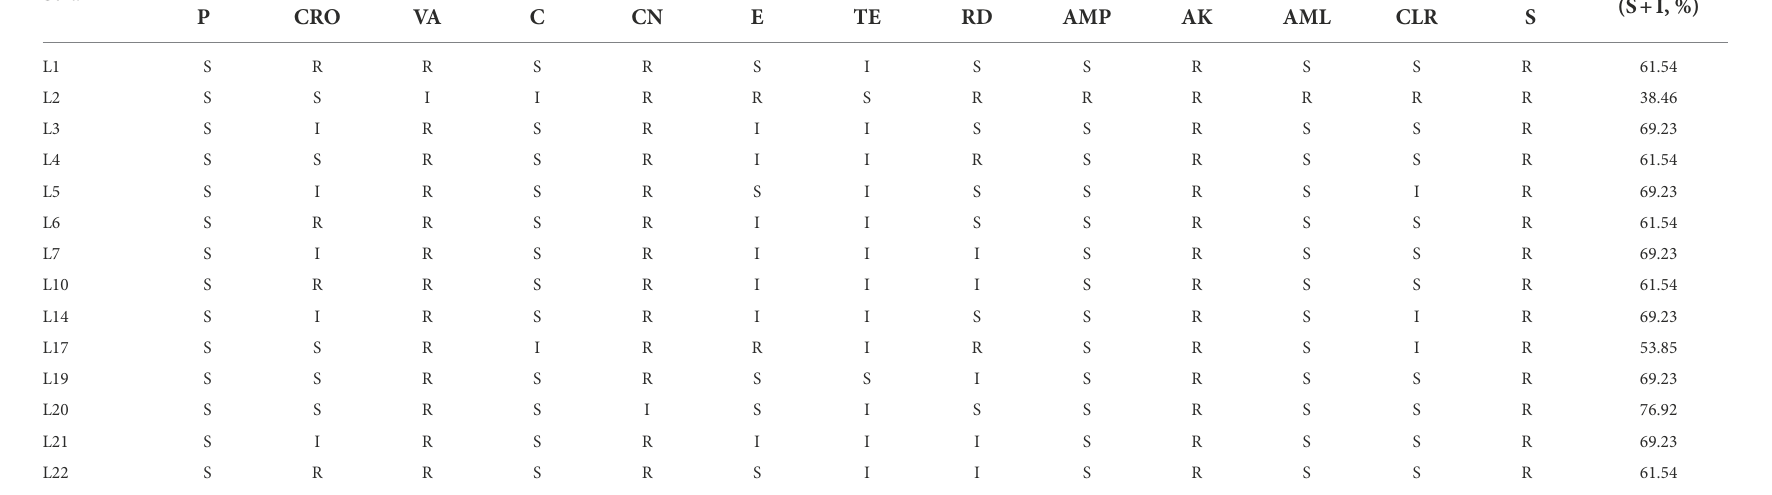
TABLE 5 Antibiotic susceptibility results of LAB isolates from